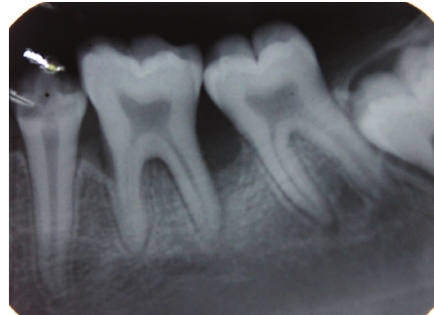
Figure 10: Intraoral periapical radiograph showing vertical bone loss in relation to 36.